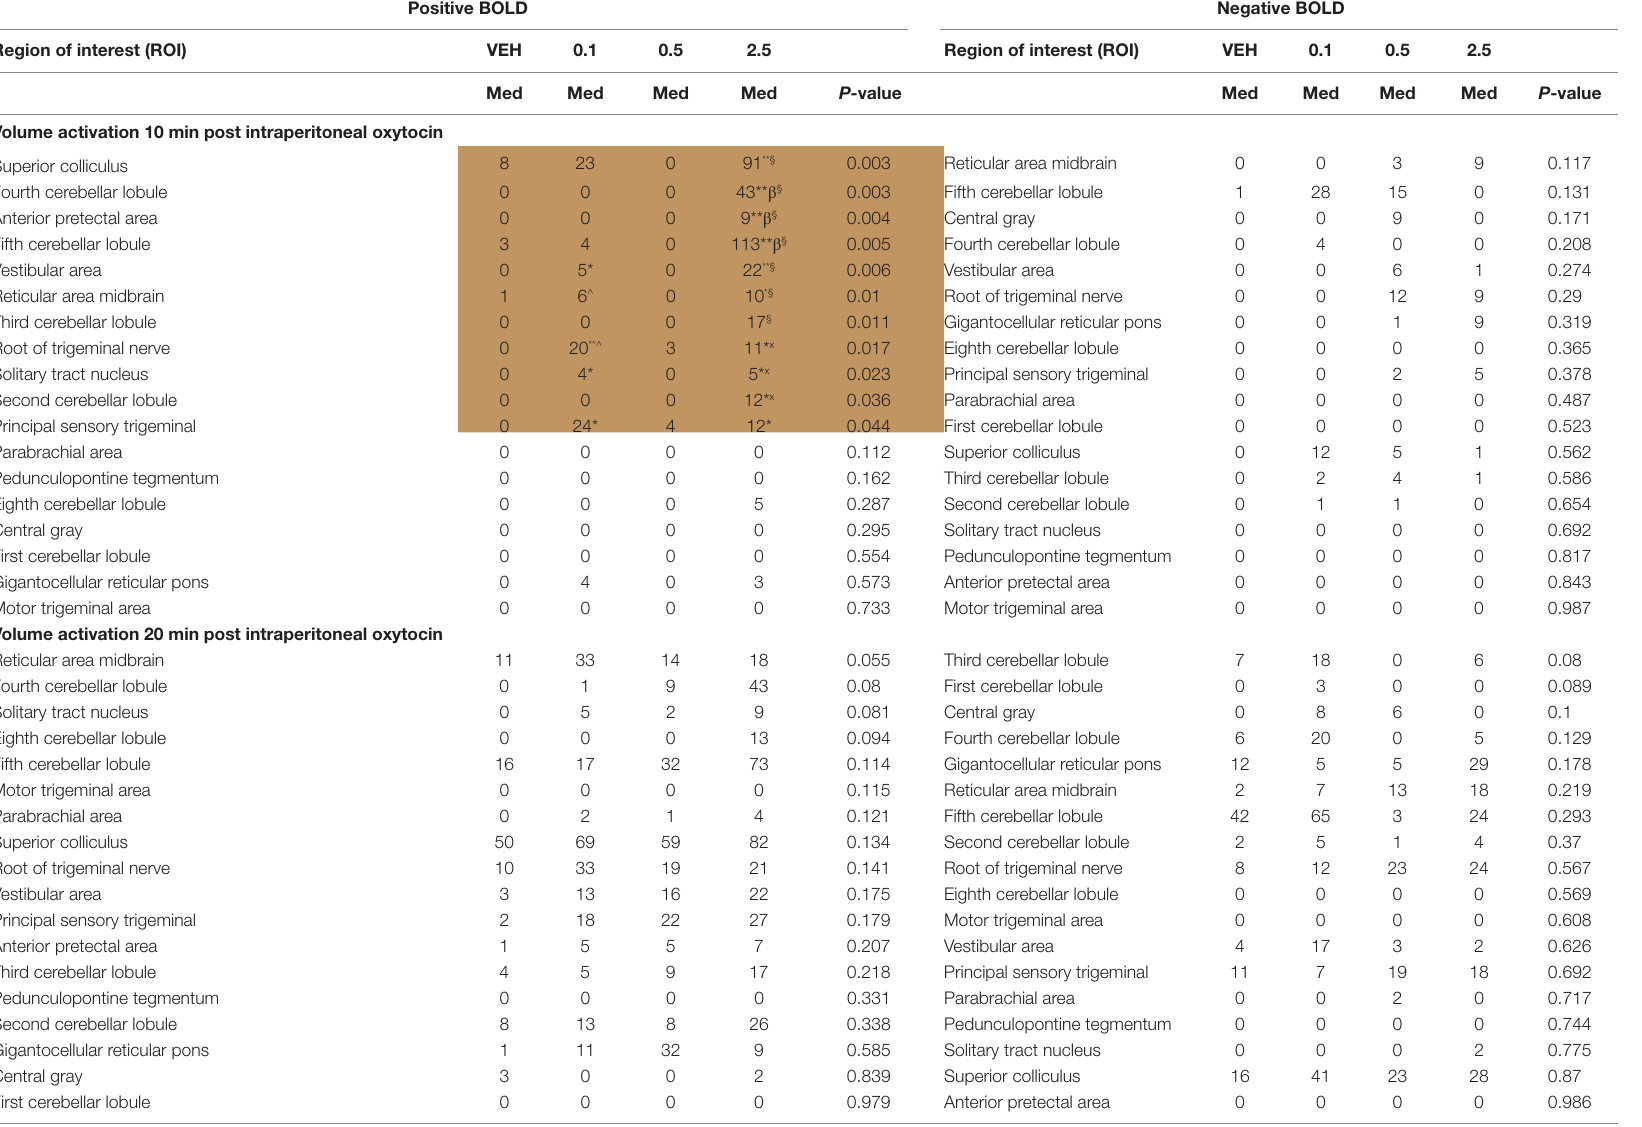
TaBle 1 | activation in brainstem and cerebellum following intraperitoneal